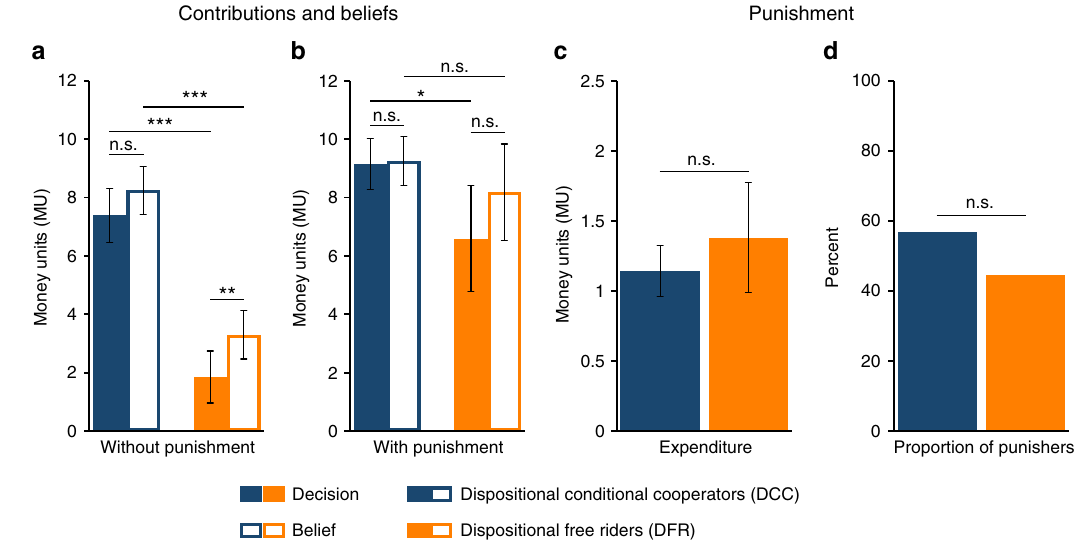
Fig. 1 Contribution and prosocial punishment behaviour of DCC and DFR. a Contributions and beliefs in the without punishment treatment ( N DCC = 41; N = 27). Asterisks refer to Mann – Whitney/Wilcoxon signed-rank tests; n.s. P ≥ 0.10; ** P < 0.05; *** P < 0.01. b Contributions and beliefs in the with DFR punishment treatment ( N DCC = 49; N DFR = 22). Asterisks refer to Mann – Whitney/Wilcoxon signed-rank tests; n.s. P ≥ 0.10; * P < 0.10; *** P < 0.01. c Average expenditure on prosocial punishment. n.s. P > 0.10; Mann – Whitney test. d Proportion of punishers engaged in prosocial punishment. n.s. P > 0.10; χ 2 test. The error bars indicate ± 1